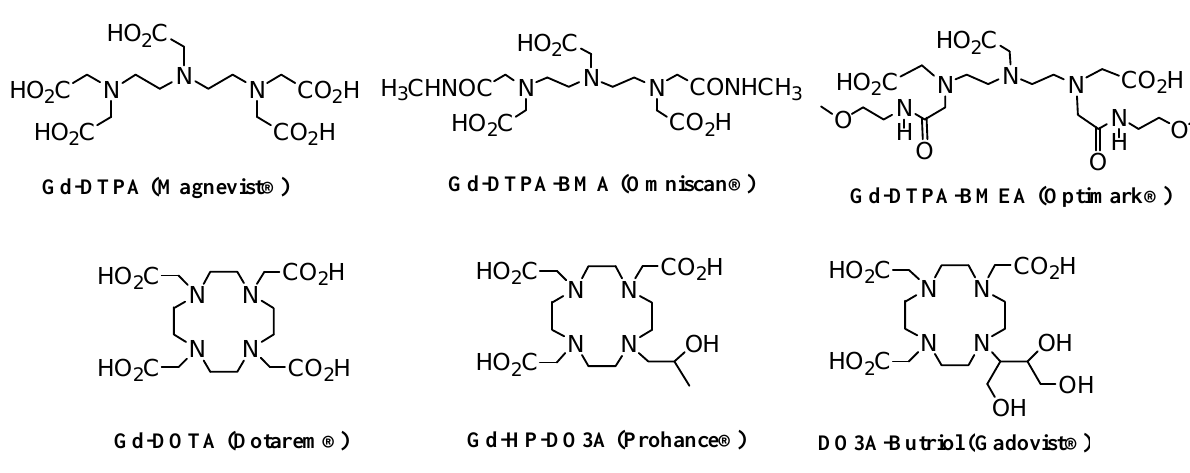
Figure 2. Gd(III) complexes commonly used in clinical